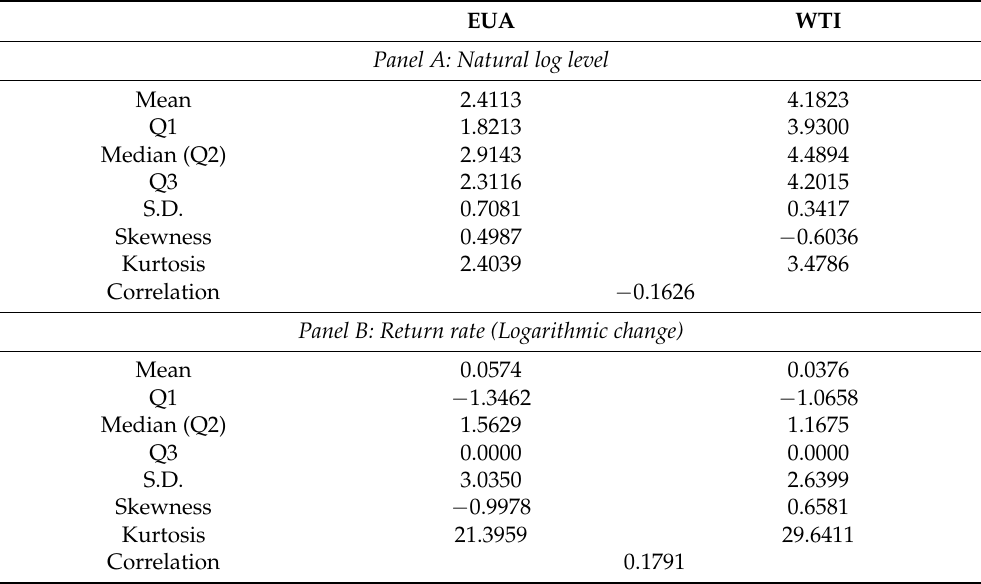
Table 1. Basic statistics of EUA and WTI.